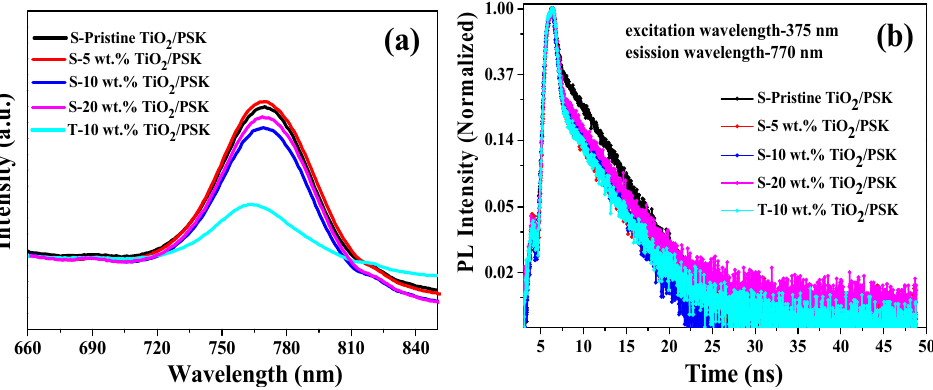
Figure 7. Carrier transfer characterization of ( a ) Steady state photo-luminescence (PL) spectra and ( b ) time-resolved PL spectra for perovskite (PSK)/m- TiO 2 without or with Ag NPs concentration of 5 wt.%, 10 wt.% and 20 wt.% embedded in c- TiO 2 / FTO. Table 2. The calculating parameters of the perovskite samples with various Ag NPs concentration in TiO 2 from the time resolved photoluminescence (TRPL) measurement.